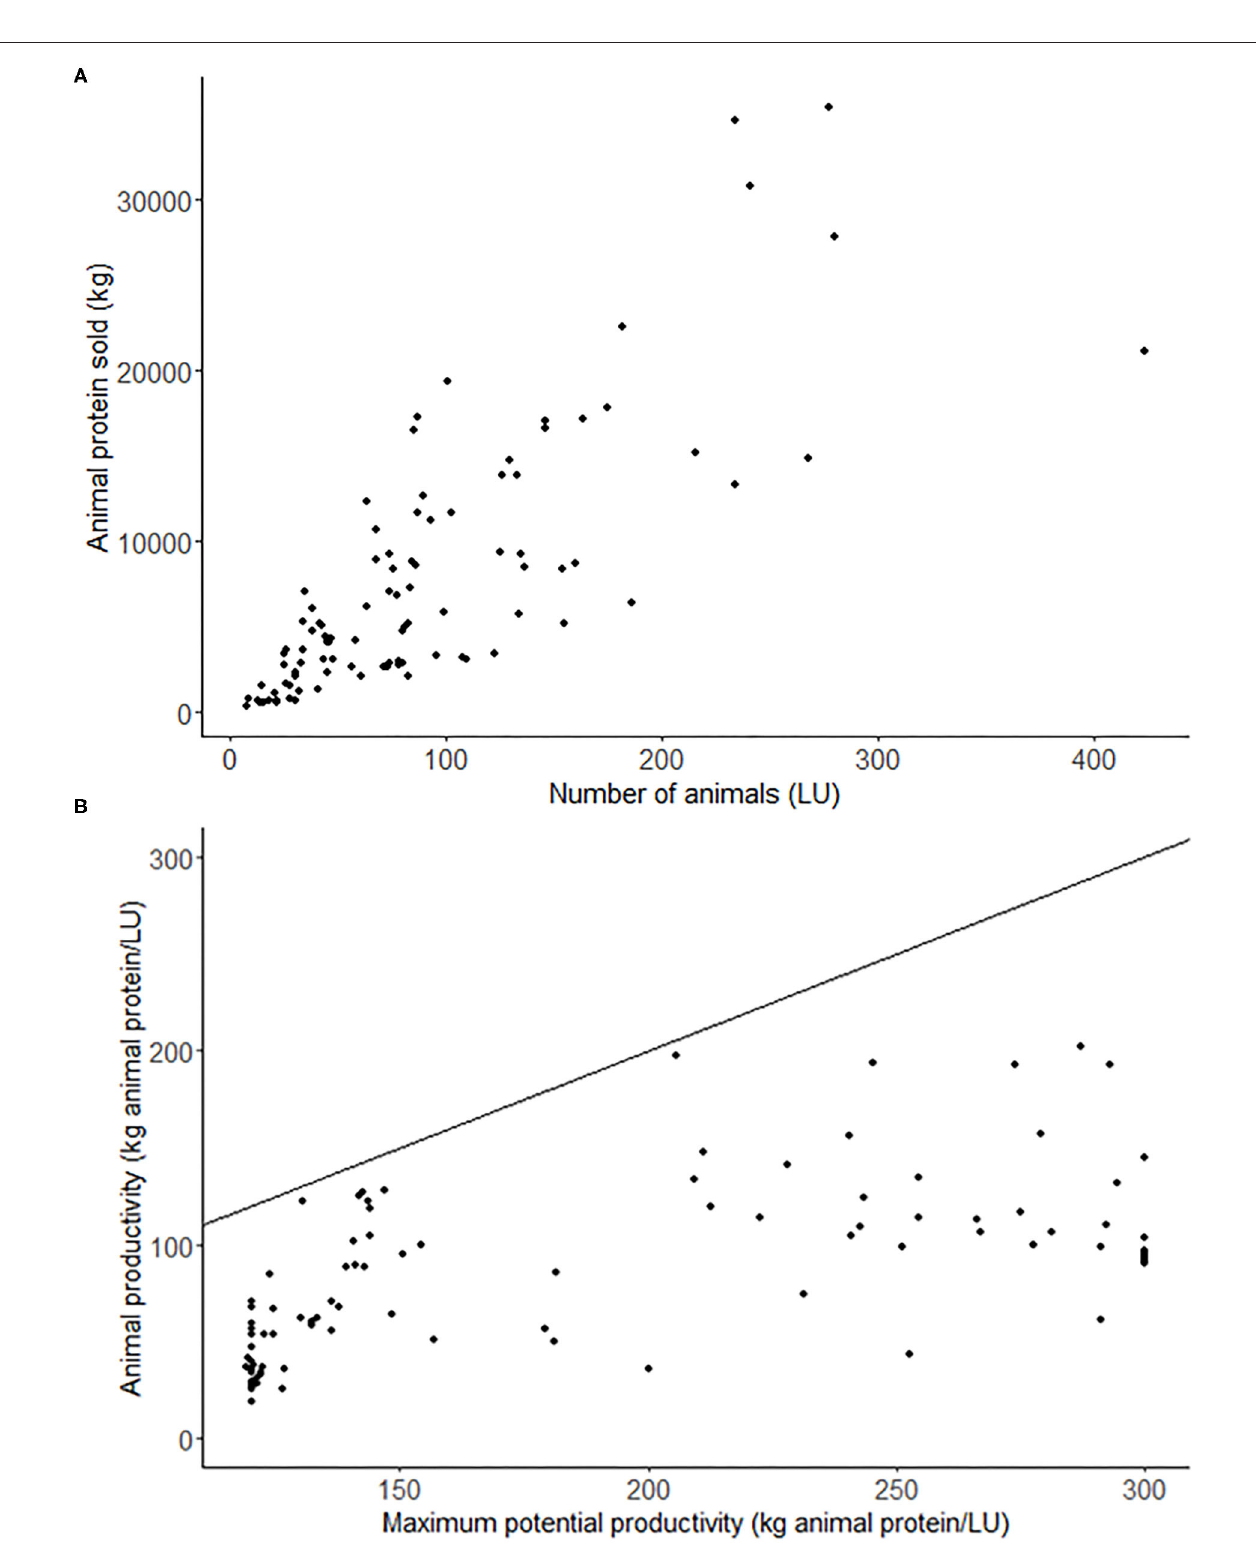
FIGURE 1 | Graphs used for data validation. (A) Animal protein sold according to the number of LU at farm level; and (B) Animal productivity (in kg of animal protein per LU) depending on the maximum potential productivity (in kg of animal protein per LU). The black line represents the calculated maximum productivity which is achievable for that number of